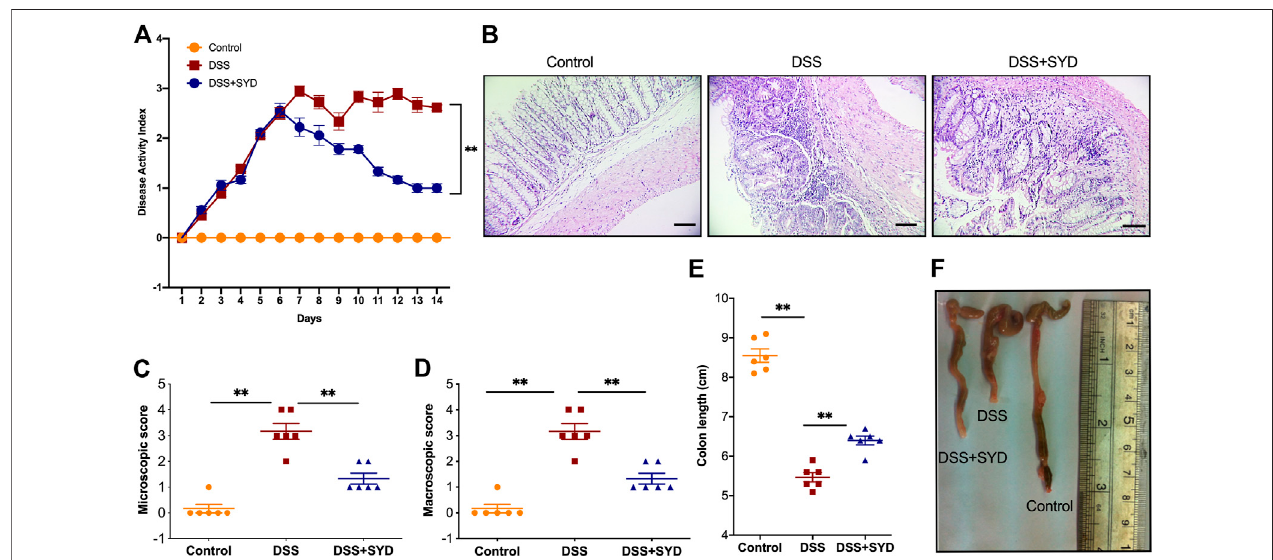
FIGURE 2 | SYD protects mice from DSS-induced colitis (A) DAI scores were calculated (B) Serial sections of colon tissues were stained with hematoxylin and eosin (H&E). Scale bars (cid:2) 100 μ m (C, D) Microscopic and macroscopic score measurement (E, F) Colon length measurement. Dataare presented as the mean ± SEM, n (cid:2) 6 per group. * p < 0.05, ** p < 0.01.